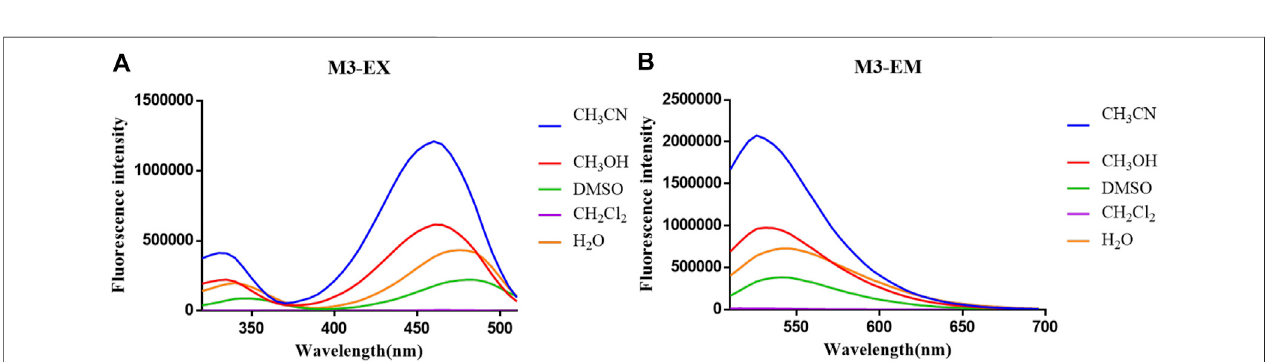
FIGURE 4 | (A) Fluorescent excitation and (B) emission spectra of probe M3 in different solvents.